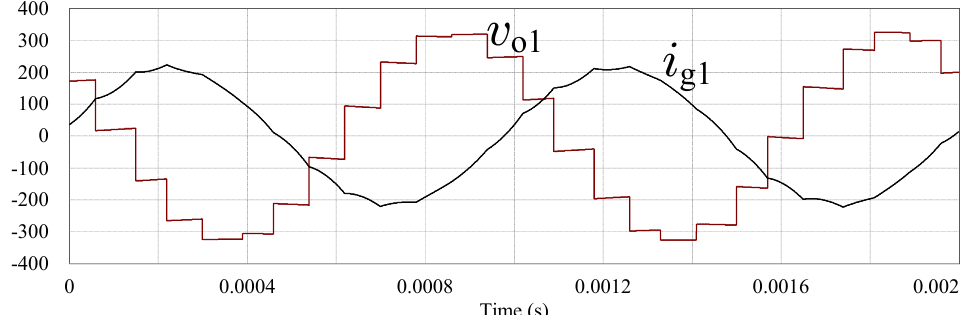
Figure 26. MMCCR converter’ output voltage v o1 and the generator current i g1 for NVM modulation: THD ( i g1 ) = 3.5% and THD ( v o1 ) = 16%.